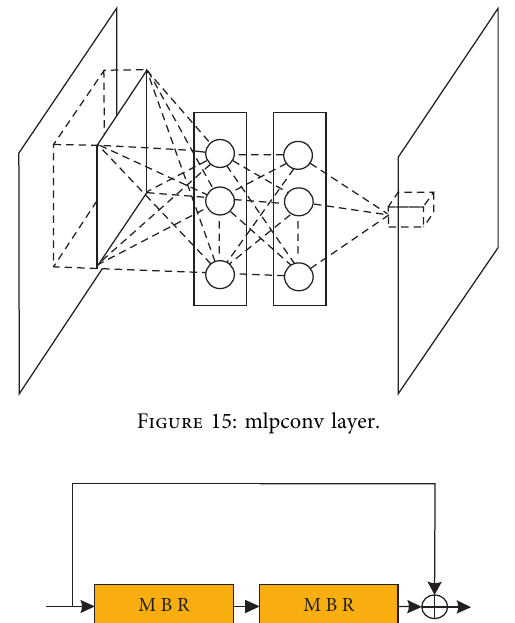
Figure 16: The scheme of a possible residual connection in a CNN.